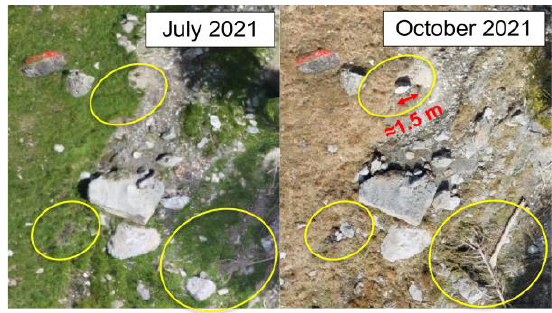
Figure 11. Details of displaced boulders between July and September 2021.